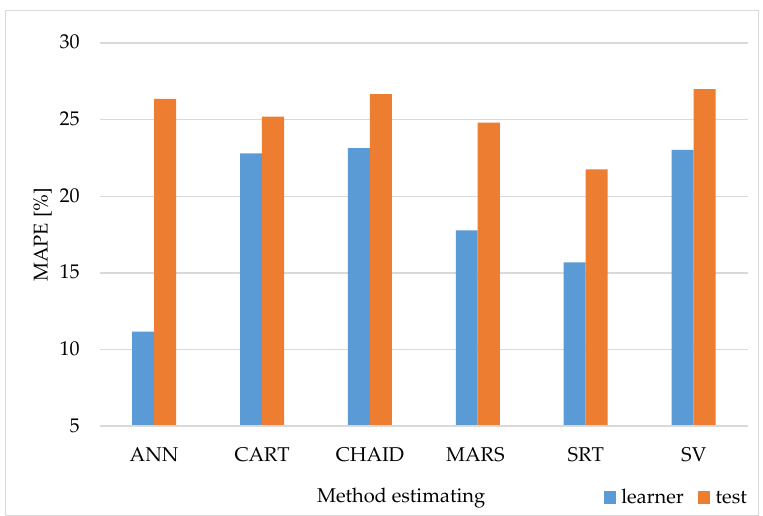
Figure 5. Comparison of the average quality indicators ( MAPE ), of selected methods estimating the reduction energy requirements for all accessible taking into account all accessible input variables (sets I–V).